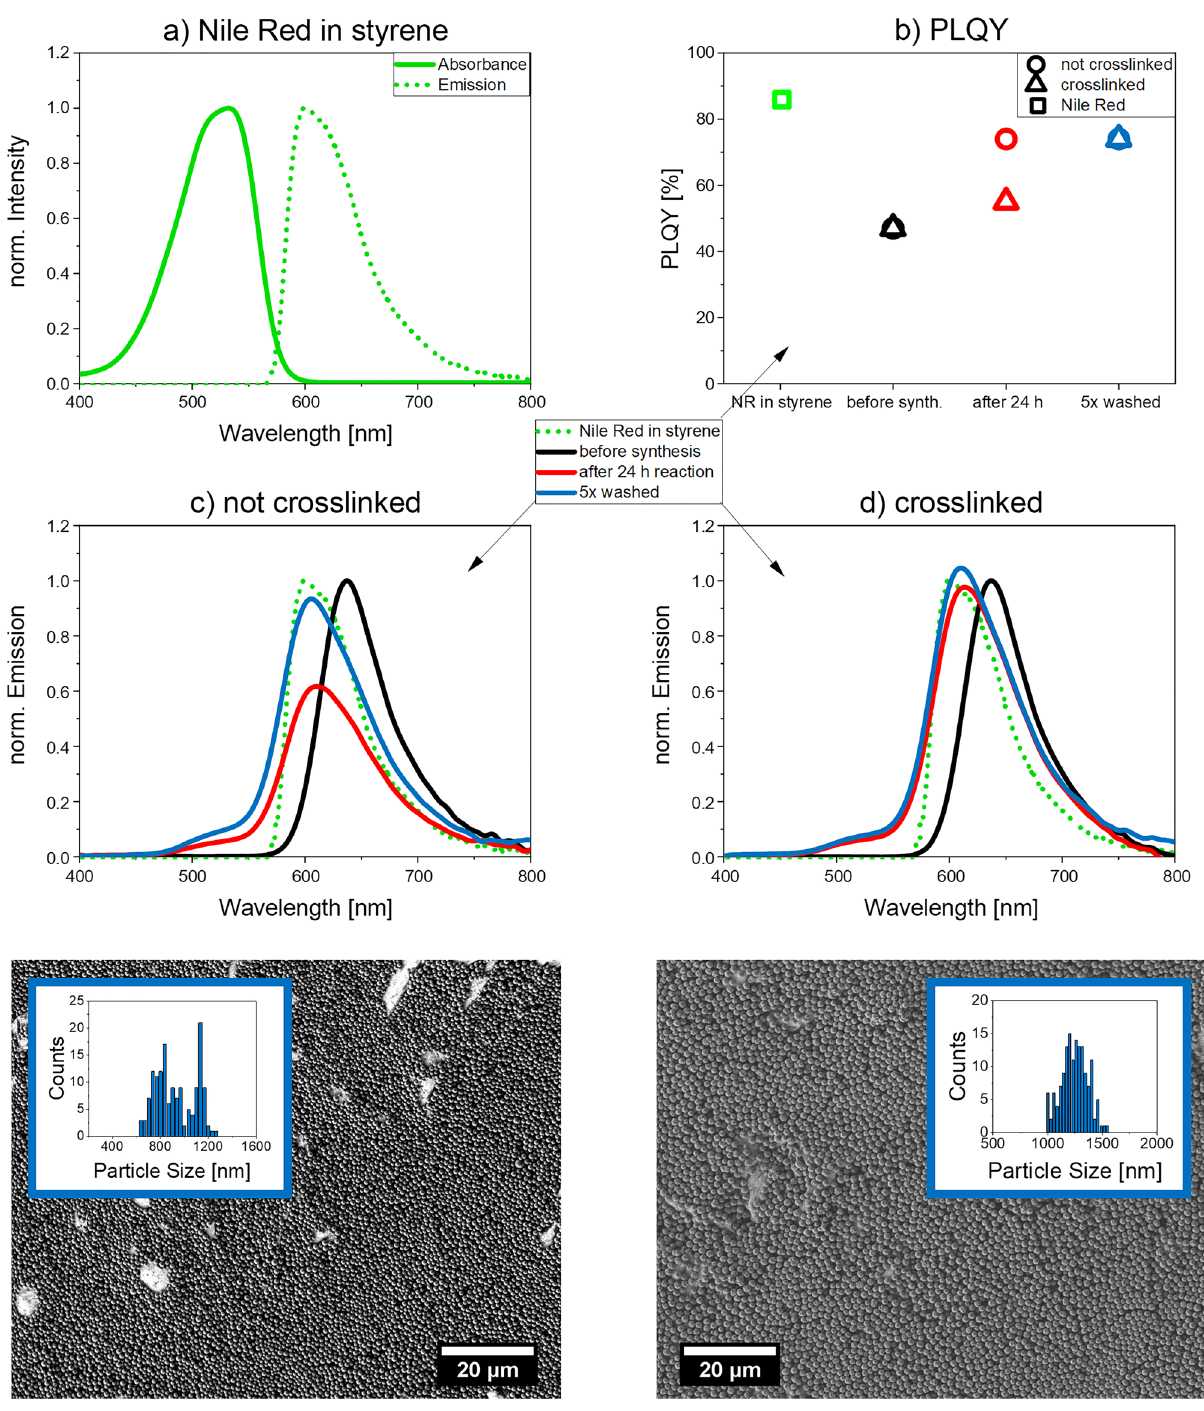
Figure 3. Luminescence properties of NR and NR-encoded PS microbeads. ( a ) Normalized absorbance and emission spectra (λ exc = 350 nm) of NR in styrene; ( b ) PLQY of NR in styrene and in the resulting microbeads in ethanol at different stages; emission spectra (λ exc = 350 nm) of NR-encoded PS microbeads in ethanol prepared ( c ) without and ( d ) with addition of 200 µL of the crosslinker DVB. The emission spectra were normalized to the black emission spectra of the dye NR recorded in the initial reaction mixture prior to polymerization to visualize polymerization-induced changes in fluorescence. For the preparation of the dye-encoded microbeads, the following conditions were used: 65 °C, 100 mg AIBN, 36.6 mg PEG- b -PCL, 100 rpm stirring speed, and 24 h reaction